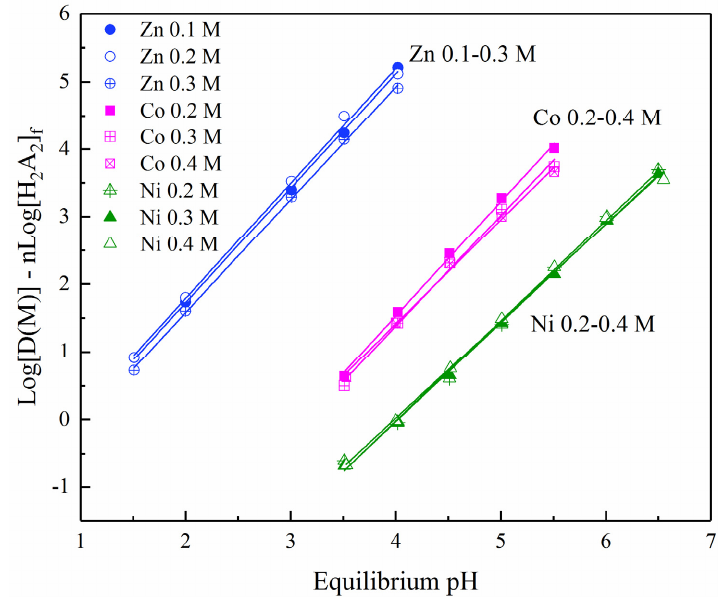
Figure 5. The linear relationship of Log D(M)-n Log [H 2 A 2 ] f and equilibrium pH for the metal extraction with Ionquest 801. Table 4. Line slope of the linear relationship of D(M)-2n Log [HA] f against pH in Figures 4 and